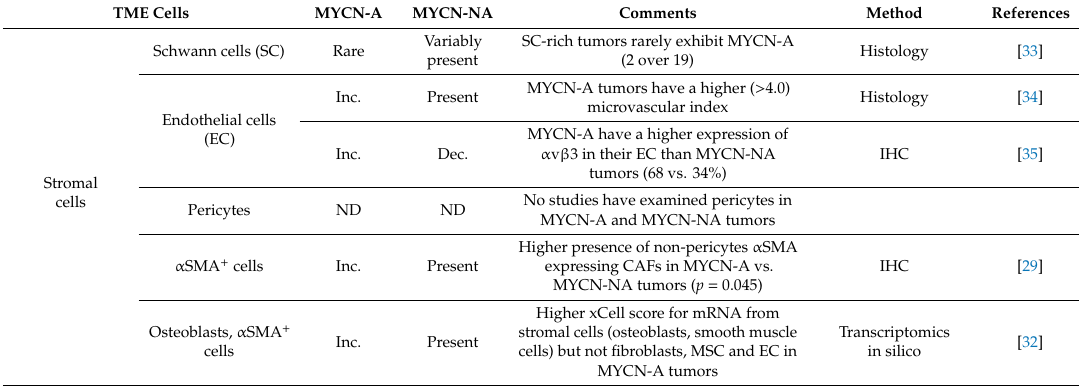
Table 1. The TME Landscape in NB Tumors: Comparison between MYCN-A and MYCN-NA